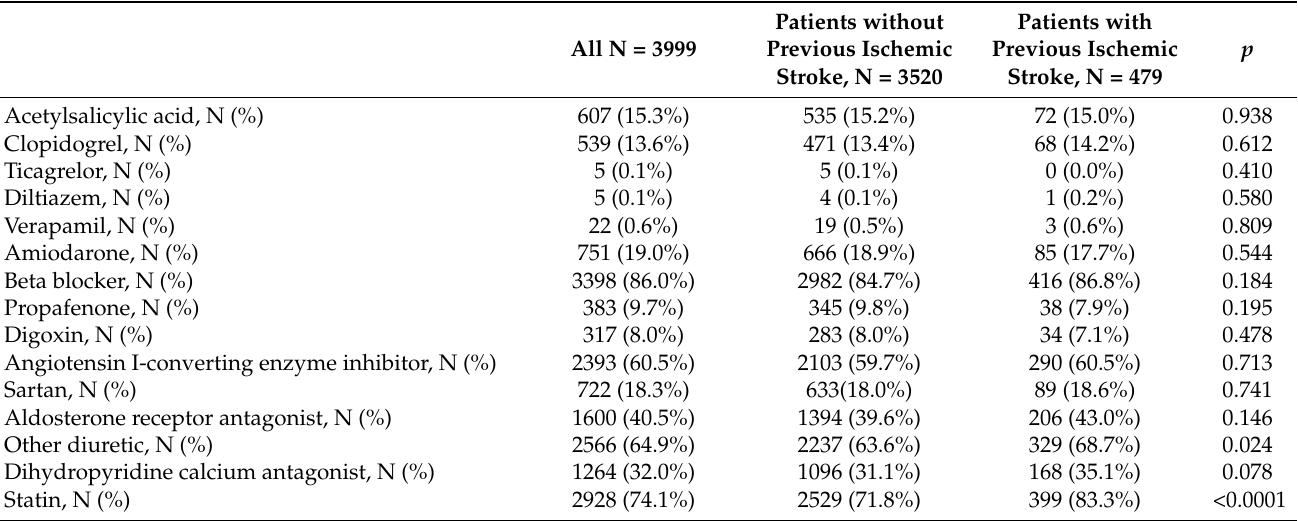
Table 3. Comparison of pharmacological treatment between patients with and without previous ischemic